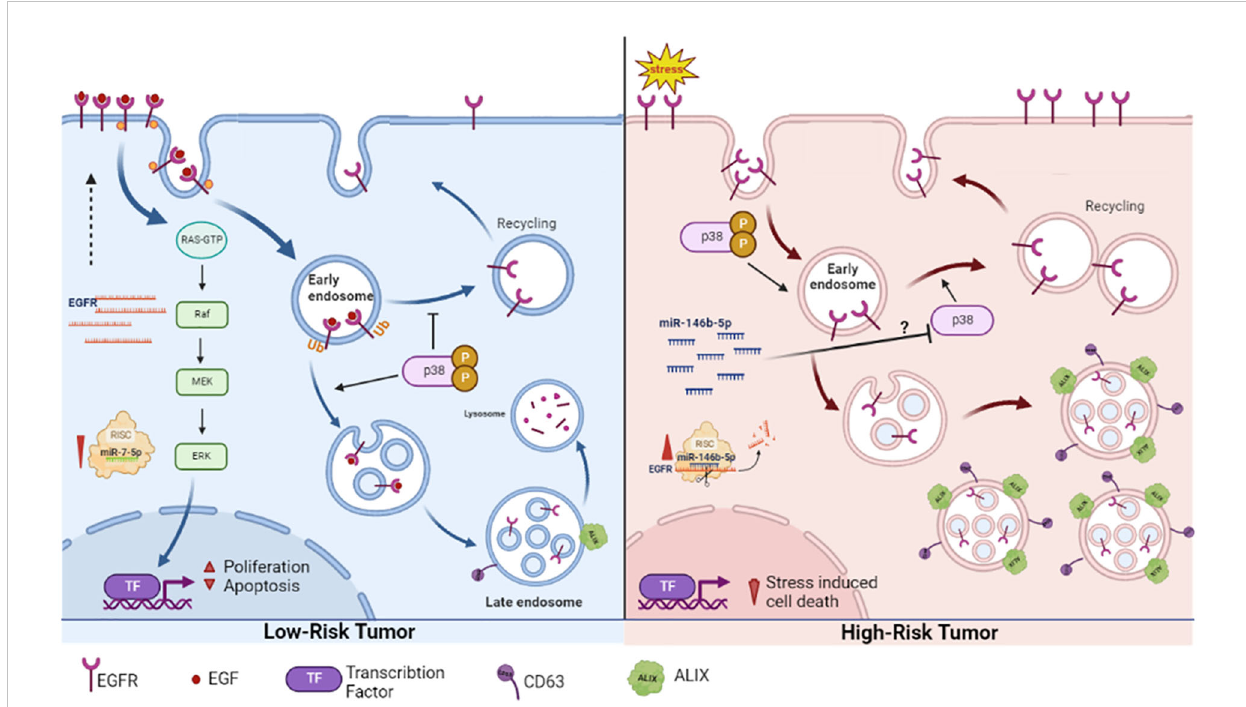
FIGURE 7 Our proposed EGFR expression regulation and spatial dynamics in low risk (NIFTP) and malignant (PTC) thyroid neoplasms. In NIFTP, EGFR transcripts are abundant in association with reduced level of miR-7-5p. EGFR protein at the plasma membrane binds to its ligand, activates the ERK pathway to stimulate proliferation. The activated receptor is then internalized into the endosomal network where it is destined for degradation. Active p38 favors internalization and represses recycling of EGFR to the plasma membrane. In PTC, EGFR transcript level is low in association with high level of miR-146b-5p and high stress levels. The stress activated EGFR gets internalized, evades lysosomal degradation and accumulates in endosomes/exosomes. The ERK pathway is not active. Inhibition of p38 possibly by miR-146b-5p supports recycling of EGFR to the plasma membrane. Created using